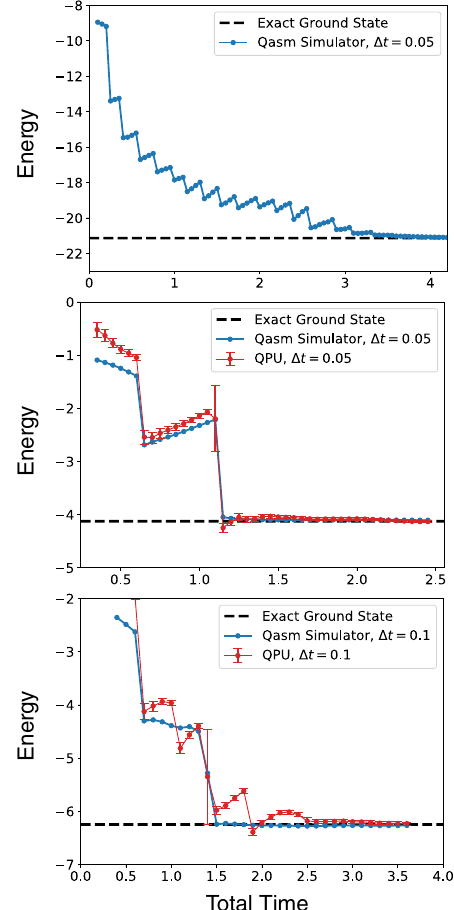
FIG. 11. The top figure shows the ground-state energy as a function of time step for the ten-qubit transverse field Ising model run on IBM’s qasm simulator with s SV = 10 − 1 . The mid- dle figure shows results for hardware runs (IBM’s Paris machine) for a two-qubit transverse field Ising model. For both the top and middle plots, VQPE and the Trotter step size are the same, (cid:10) t = 0.05. Classical processing in the middle plot (for both QPU and simulator data) used SVD cutoff s SV = 2. The bottom figure shows results for hardware runs (IBM’s Montreal machine) for a three-qubit transverse field Ising model, VQPE (cid:10) t = 0.1, Trotter step size (cid:10) t = 0.05, and s SV =